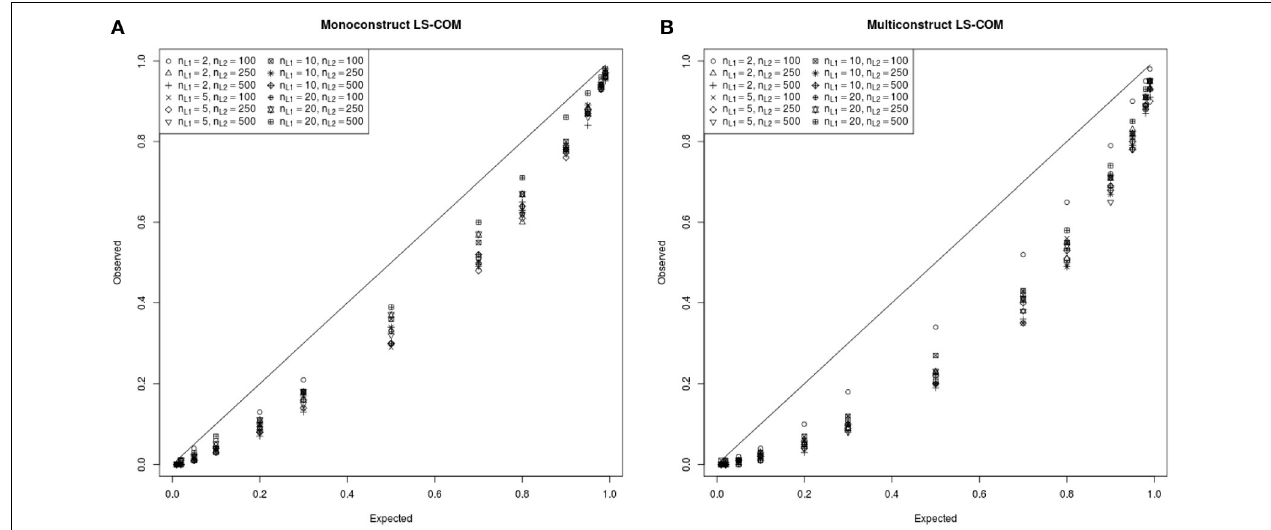
FIGURE 8 | PP-plot of the observed and theoretical proportions of the χ 2 values for the monoconstruct LS-COM model (A) and multiconstruct LS-COM model (B) for different sample